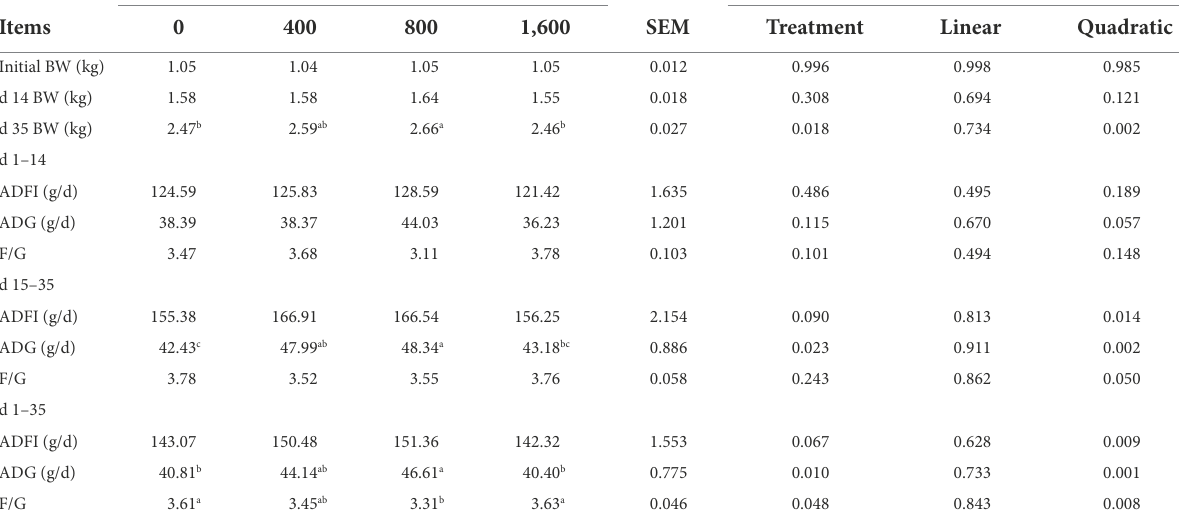
TABLE 2 Effects of CGA on growth performance of weaned